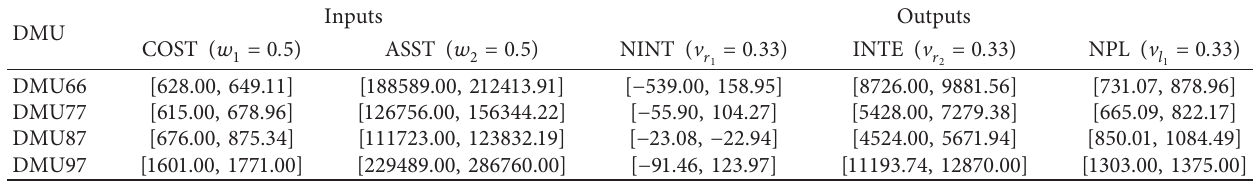
Table 2: The DMUs with negative outputs.